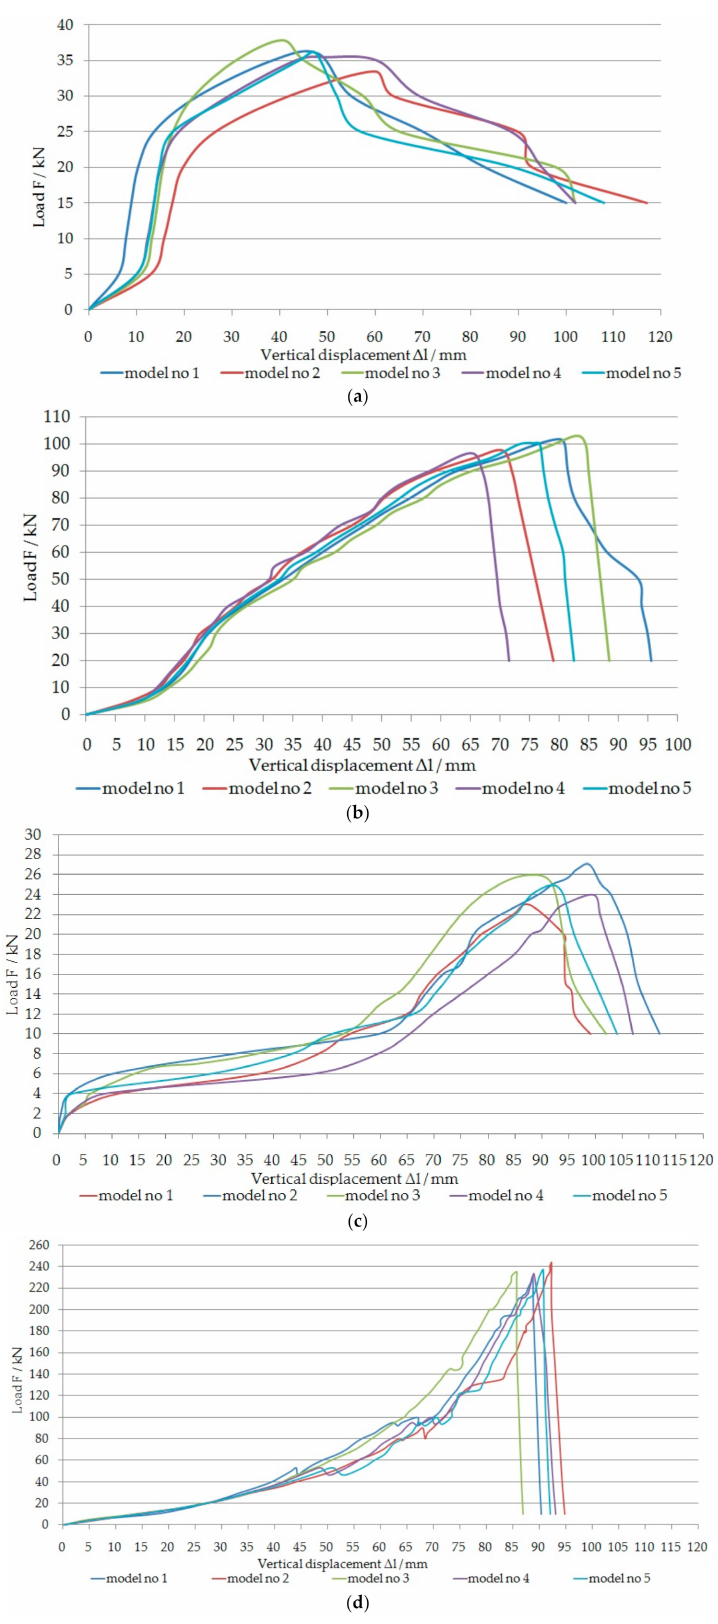
Figure 9. Load-displacement characteristics of crib models: ( a ) Three-point; ( b ) Three-point filled with gangue; ( c ) Four-point; ( d ) Four-point filled with